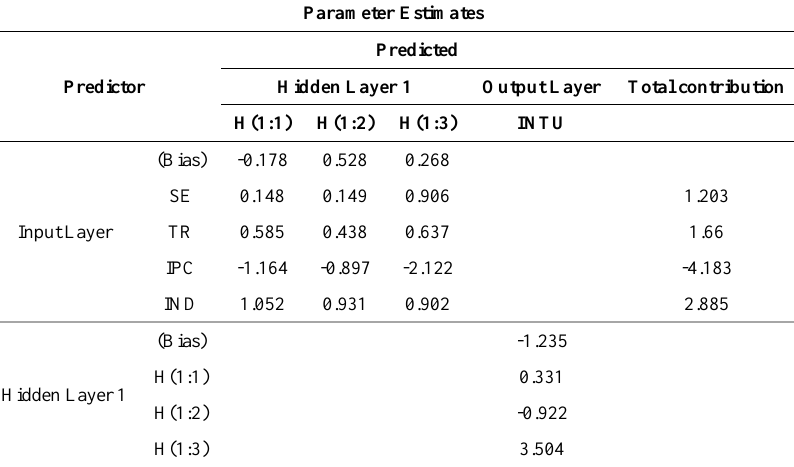
Table 7. Sensitivity Analysis: Neuronal average weights for hidden neurons Parameter